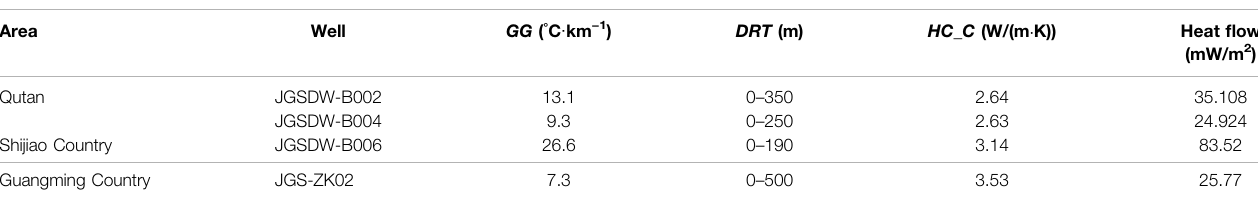
TABLE 4 | Calculated heat fl ow of each well in the study